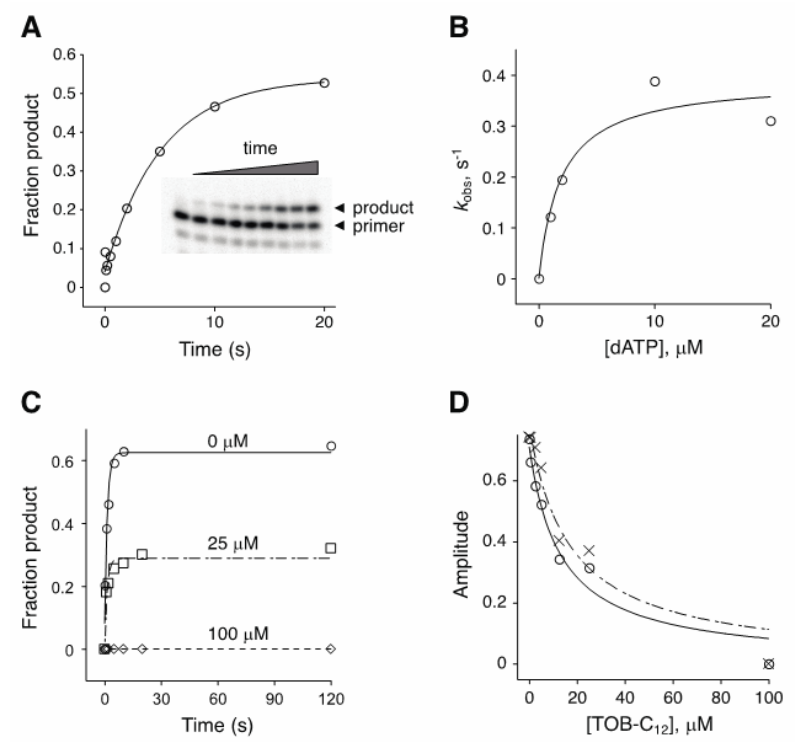
Figure 4. E ff ect of TOB-C 12 on the kinetics of single-nucleotide incorporation by AMV RT. ( A ) Example of an experiment measuring the rate of adenosine monophosphate incorporation by AMV RT upon addition of dATP (2 µ M). Primary data (inset) were quantified, plotted versus time, and fit to a single-exponential function to obtain the observed rate ( k obs ). ( B ) A secondary plot of k obs versus dATP concentration suggests a K M (dATP) of ~2 µ M. ( C ) Primer:template was incubated with or without TOB-C 12 prior to rapid mixing with dATP (150 µ M) and quenching at various times. Time courses of product formation in the absence ( ) or presence ( , 25 M; , 100 M) of TOB ‐ C 12 are shown. ( D ) Amplitude was measured as a function of TOB ‐ C 12 concentration, in reactions containing 10 M ( ) or 150 M ( ) dATP.